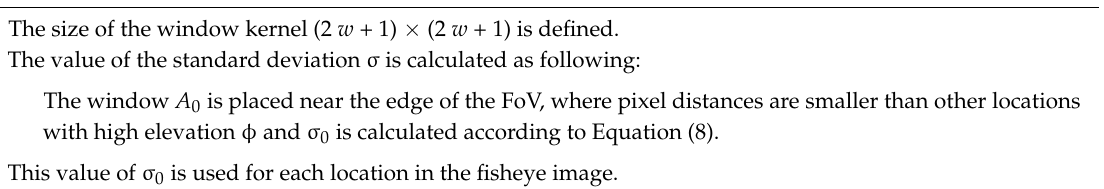
Algorithm 1. Initialization of the Gaussian kernel with small standard